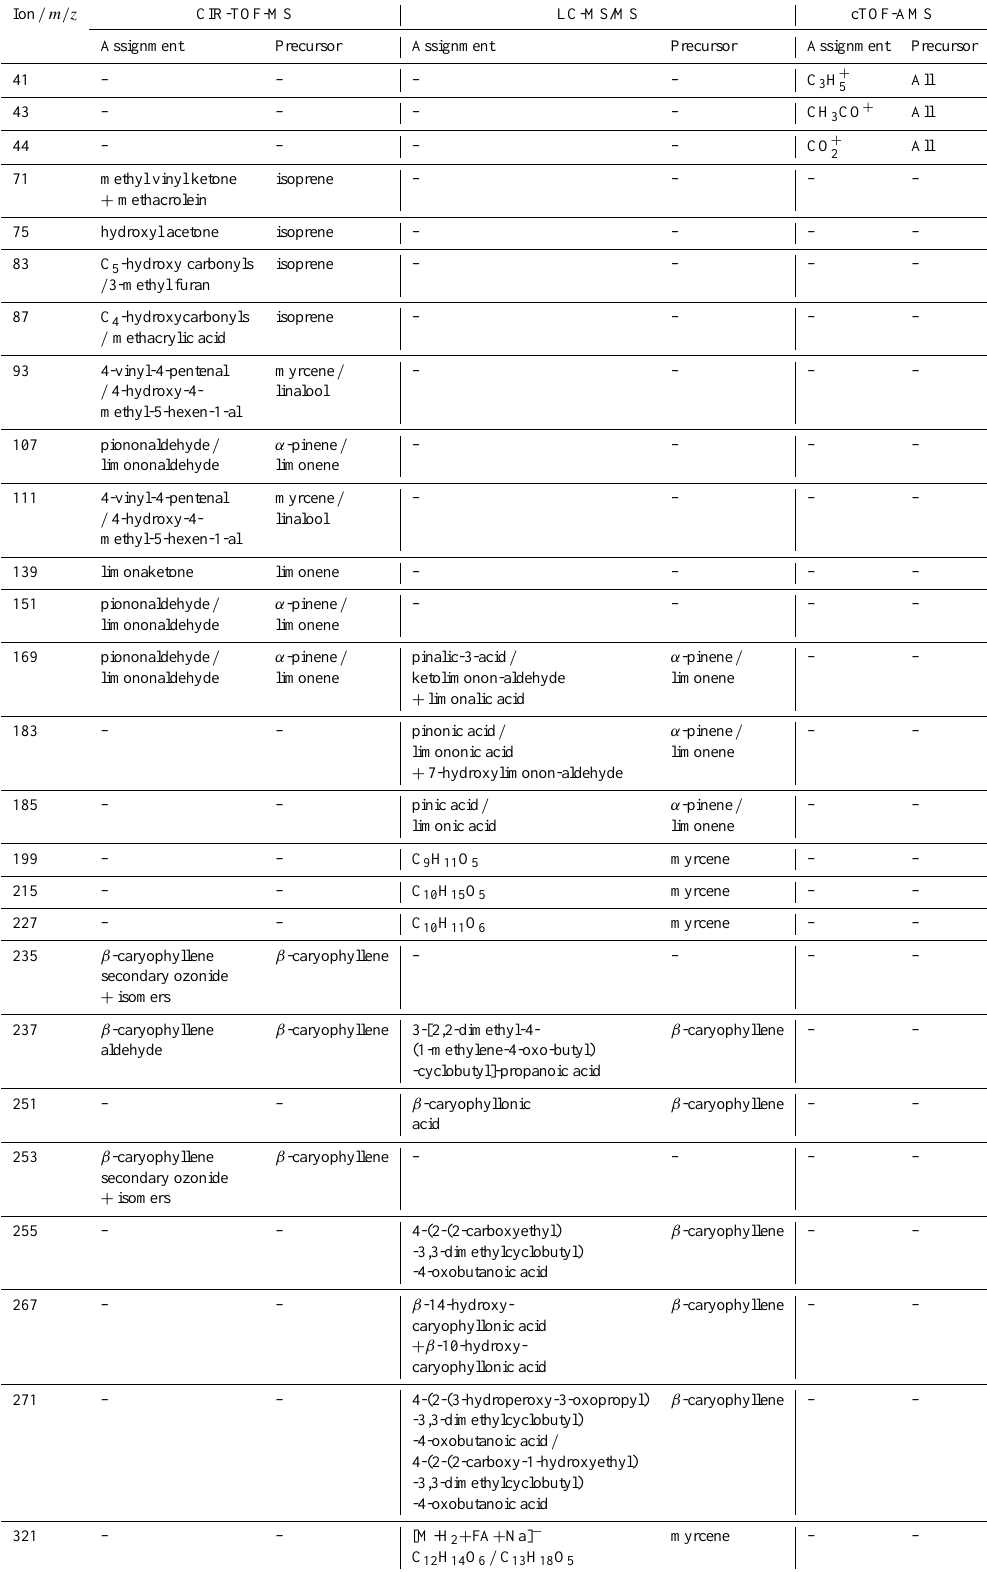
Table 3. List of certain major product ions integral to the separation of BVOC photooxidation spectra in statistical space, their corresponding tentative assignments and their precursor. See main text (Sects. 4.2 and 4.5) for further